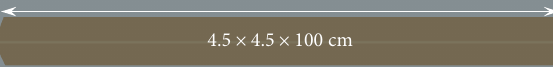
Table 2: The physical properties of tight reservoirs samples. Sample